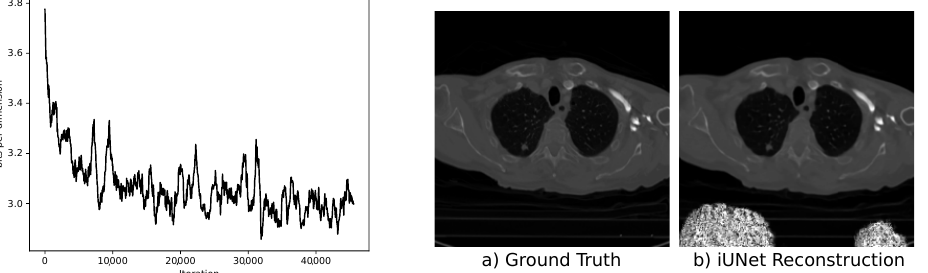
Figure 10. ( Left ) Moving average of loss during training. ( Right ) Ground-truth image from the LoDoPaB test dataset and the corresponding iUNet reconstruction. The pixels in white visualize exploding values in the